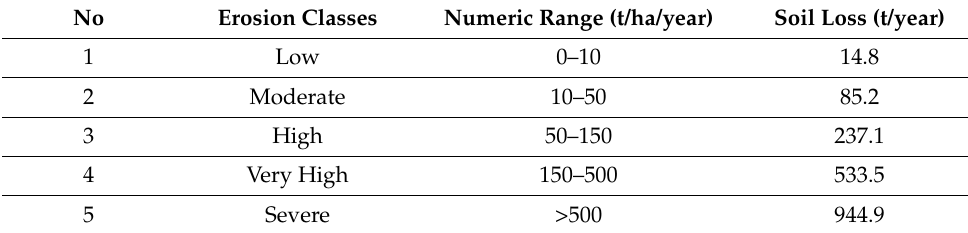
Figure 8. The potential soil erosion map of the study area. Table 4. Soil erosion classes and range of the study area.